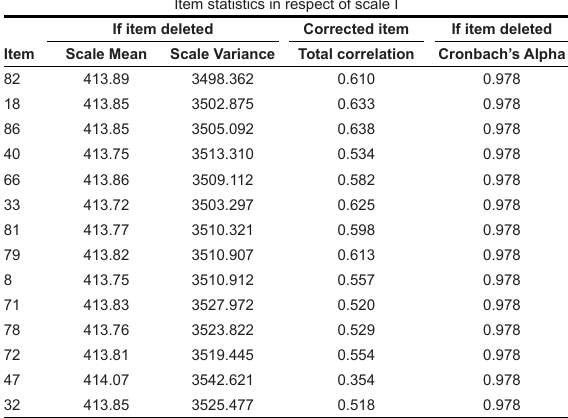
TABLE 6 Item statistics in respect of scale II